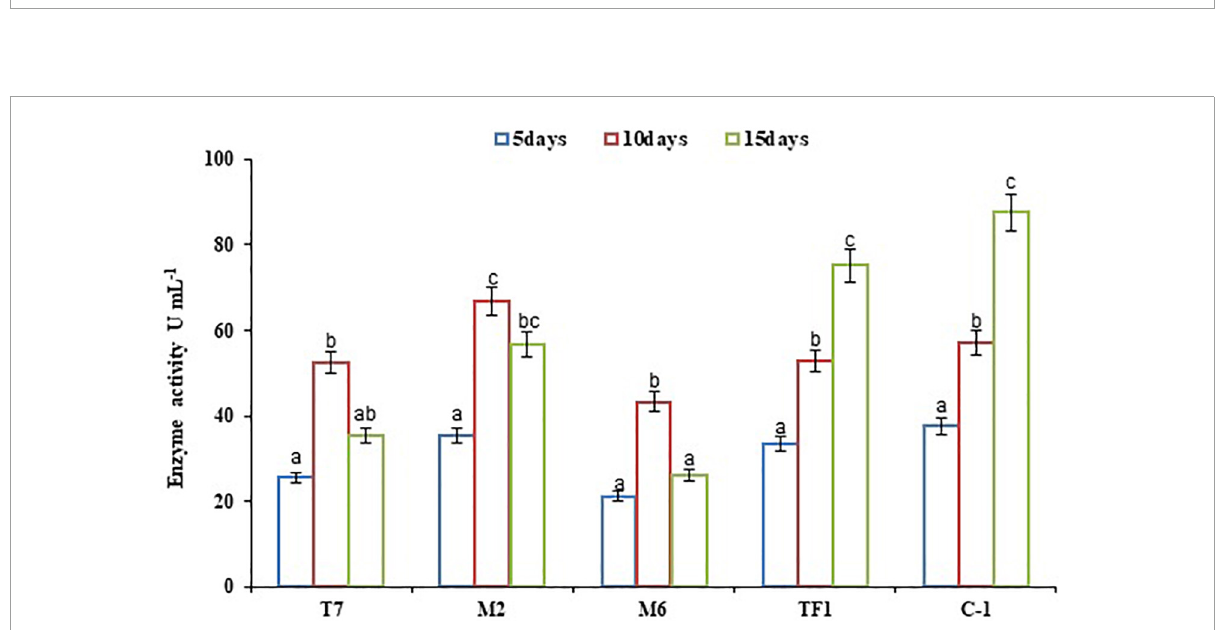
FIGURE2 Laccase activity by individual strains and developed consortium. The results were the average of five replicates ( n = 5). Bars represent the standard error. Significant differences based on the analysis variance (ANOVA) are shown by different letters above the error bars, followed by the post-hoc DMRT test ( p ≤ 0.05) using the software